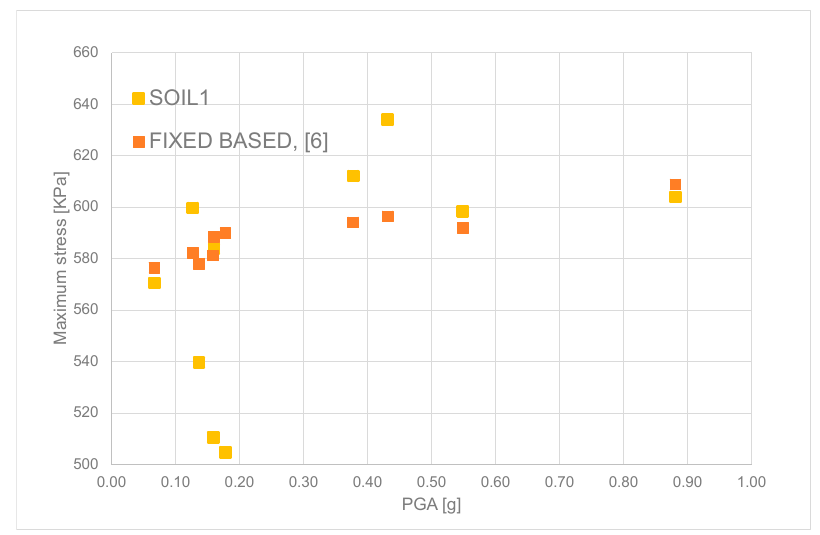
Figure 5. Comparison between results from Soil 1 and fixed based model.